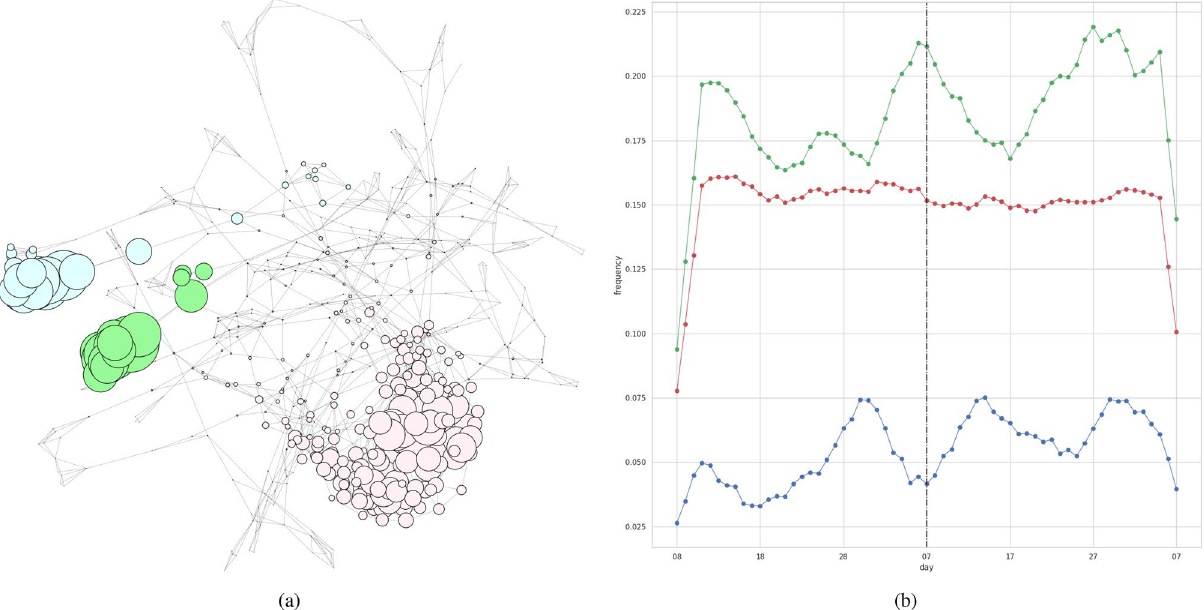
Figure 1. Results for IPCA. The first, second, and third trend clusters are denoted by red, blue, and green, respectively. B was set to 6, yielding a Q of 0.156. ( a ) The obtained trend clusters. The size of each node is determined by the degree to which the corresponding trend belongs to its clusters. ( b ) Time series signals for each cluster. We show averages of all trends in each cluster. The vertical line indicates the day of the